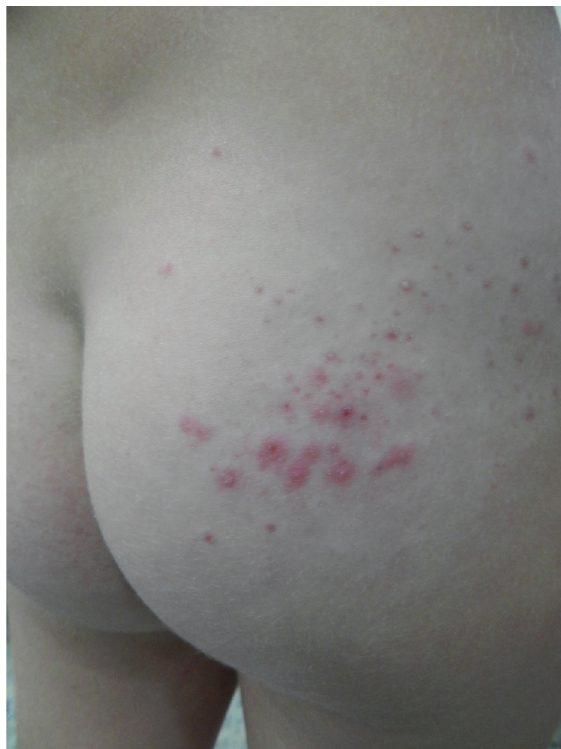
Figure 3 - Detail of pruritic erythematous papules located on the right gluteal